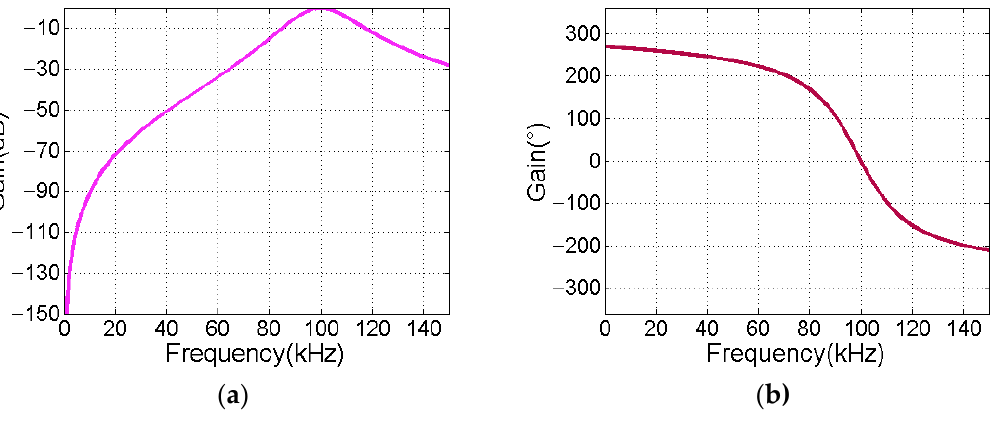
Figure 12. Frequency response of band pass filter. ( a ) Amplitude response; ( b ) Phase response.